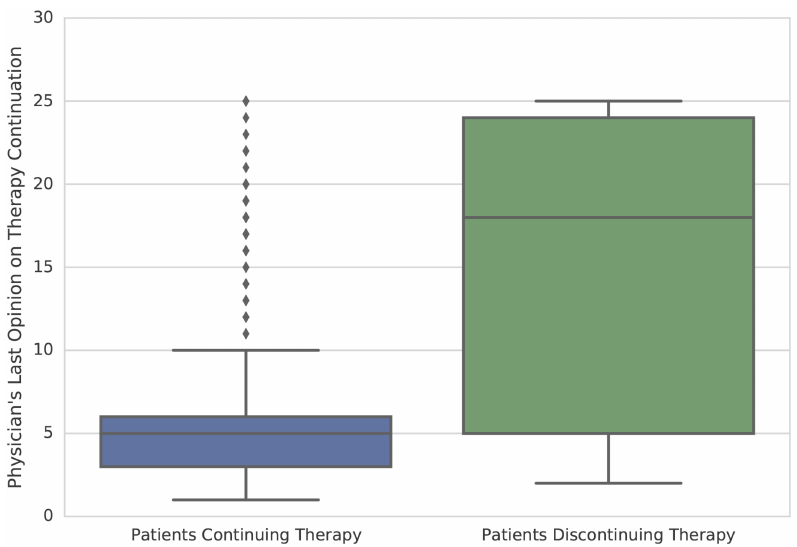
Fig 3. Significant relationship between physicians’ last statement on continuation or discontinuation of natalizumab and the proportion of patients continuing or stopping therapy. Physicians’last judgment on continuation of therapy on a visual analogscale from 0 to 25 points (1 = ‘rather continue natalizumab’, 25 = ‘rather discontinue natalizumab’) had an influenceon the proportionof patients continuing/ discontinuing